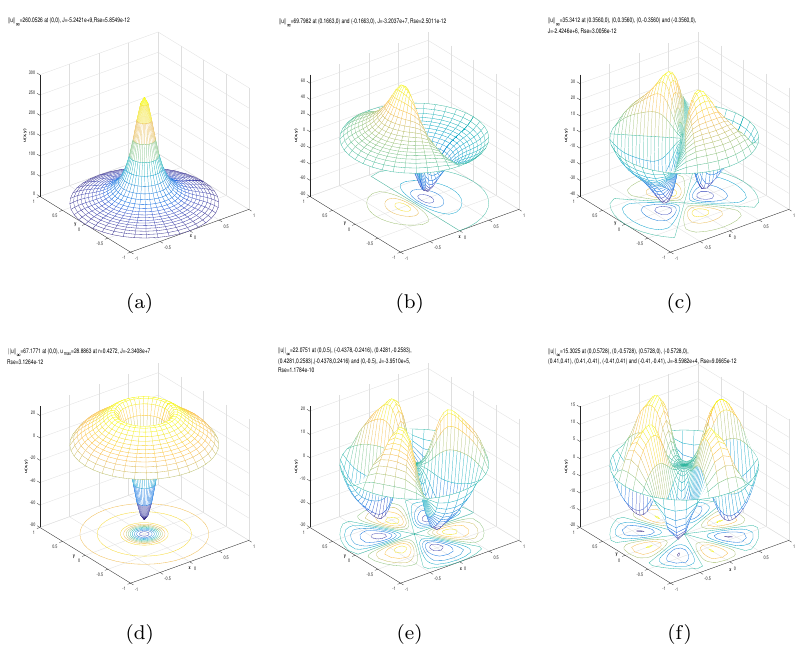
Figure 3. (a) λ 0 = 5 . 78449, O (2) symmetry; (b) λ 0 = 14 . 67342 , Σ 1 symmetry; (c) λ 0 = 26 . 33997 , Σ d symmetry; (d) λ 0 = 30 . 46207 , O (2) symmetry; (e) λ 0 = 40 . 59751, D 3 symmetry; (f) λ 0 = 57 . 31138 , D 4